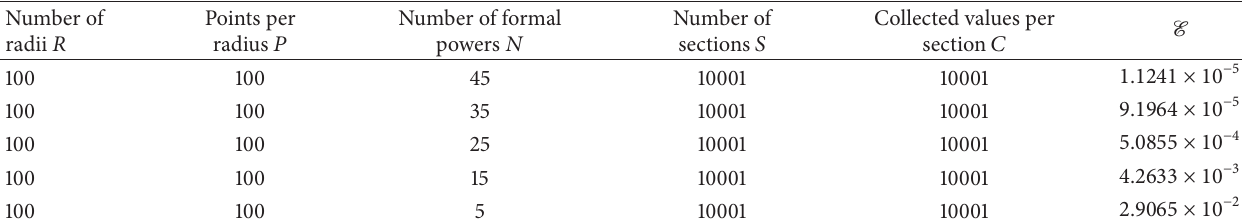
Table 6: Relation between the error E and the number of formal powers 𝑁 , when 𝜎 = (𝑥 2 + 0.1) Number of radii 𝑅